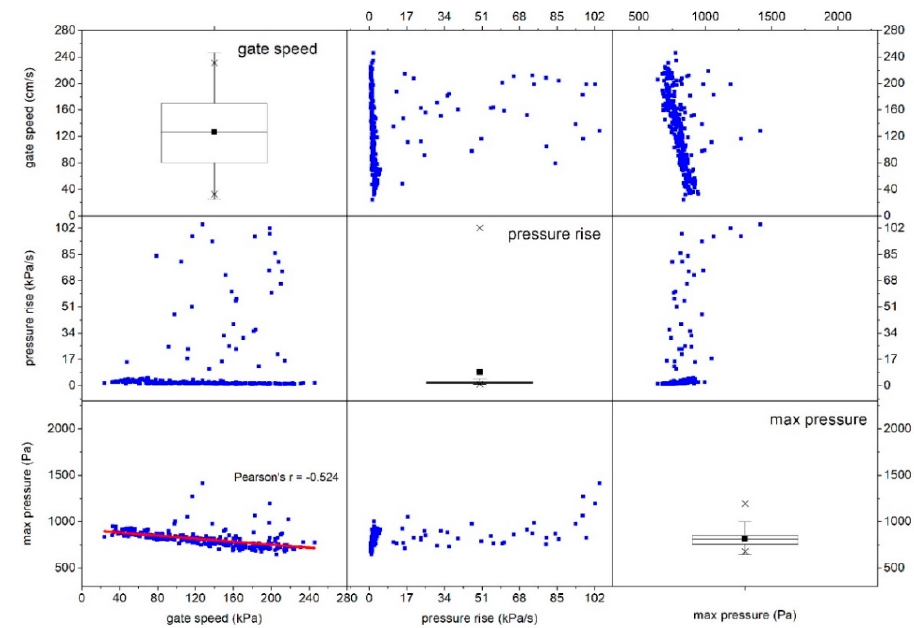
Figure A4. The matrix presenting the relationship between maximum pressure, pressure rise rate, and gate speed at Ch4.